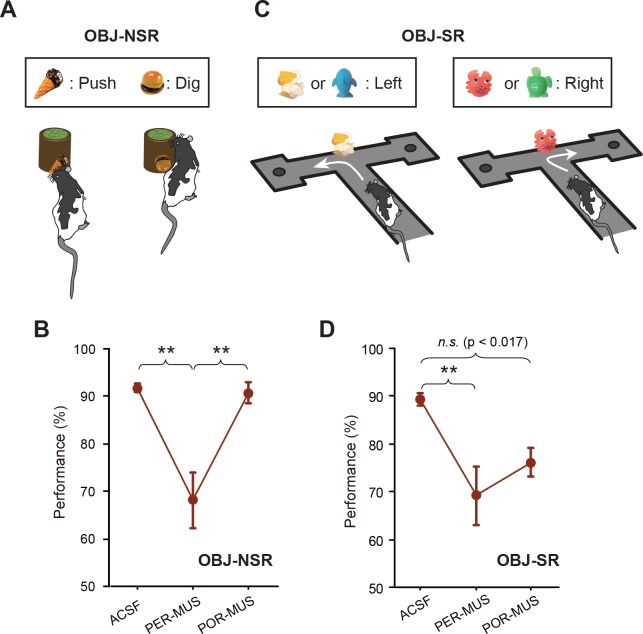
Object-memory tasks.(A) Rats made a nonspatial choice (push or dig) toward the sand-filled jar depending on the object cue attached to the jar. (B) Behavioral performance in the OBJ-NSR task (Mean ±SEM). The PER-MUS condition resulted in significant deficits in performance compared to the ACSF and POR-MUS conditions. (C) Object-cued spatial response task. Rats made a spatial choice depending on the toy object attached to the intersection wall. (D) Behavioral performance in the OBJ-SR task (Mean ± SEM). A significant difference in performance was found between the ACSF and PER-MUS conditions. **p<0.01.10.7554/eLife.32657.009Figure 3—source data 1.Performance in the OBJ-NSR task.Percent correct performance for individual rats under different drug conditions in the OBJ-NSR task.10.7554/eLife.32657.010Figure 3—source data 2.Performance in the OBJ-SR task.Percent correct performance for individual rats under different drug conditions in the OBJ-SR task.